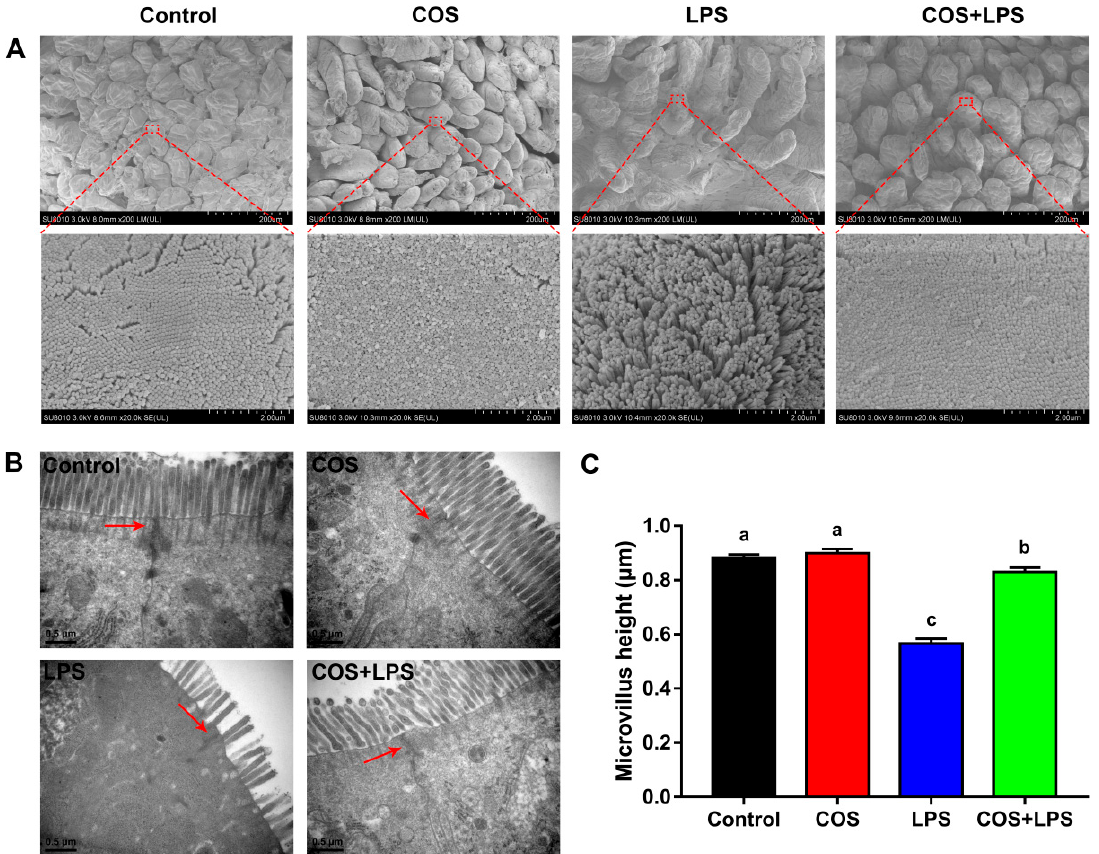
Figure 3. Effects of COS on the jejunal ultrastructure in mice. ( A ) SEM images (upper, 200 × ; lower, 20,000 × ). ( B ) TEM images (scale bar = 0.5 µ m). ( C ) Microvillus height of jejunum. The data are pre- sented as the mean ± SE ( n = 6). Values without a common letter are significantly different ( p < 0.05). COS, chitosan oligosaccharide; LPS, Lipopolysaccharide; SEM, scanning electron microscopy; and TEM, transmission electron microscopy.